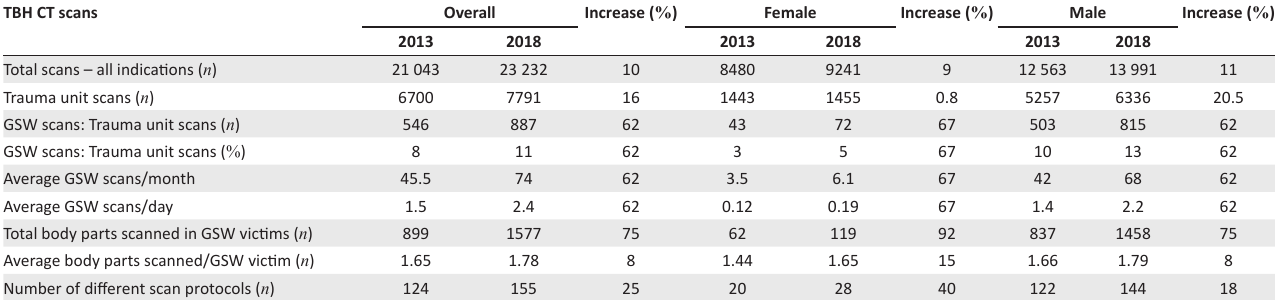
TABLE 1: Tygerberg Hospital computed tomography scans.